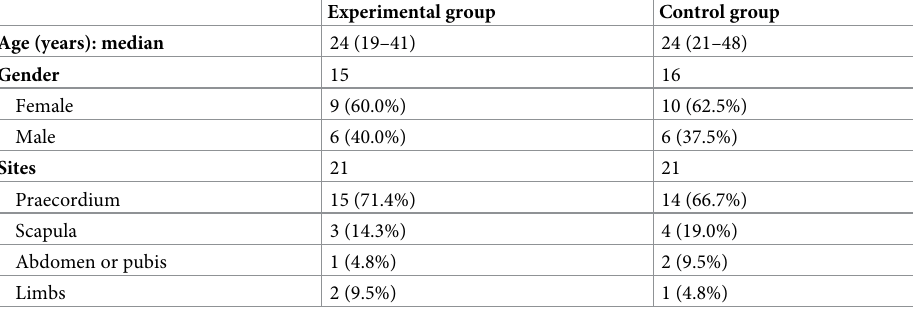
Table 1. Demographic information of recruited patients and